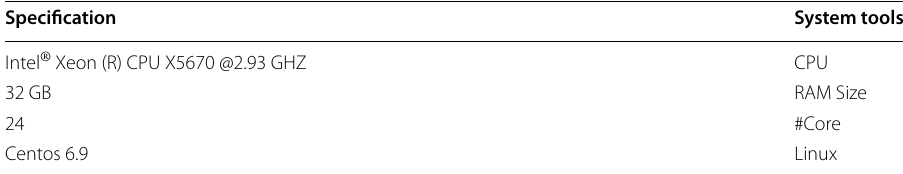
Table 1 Characteristics of the system used for data processing